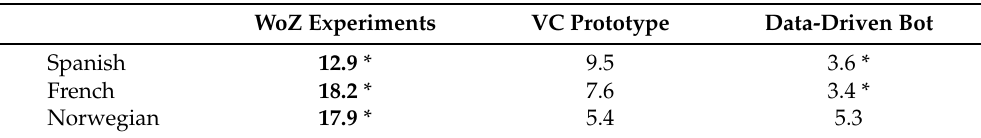
Table 7. Average number of words per user turn in WoZ, automatic VC, and coaching chatbot tests. The mark * indicates statistical significance, and bold values indicate the best results.